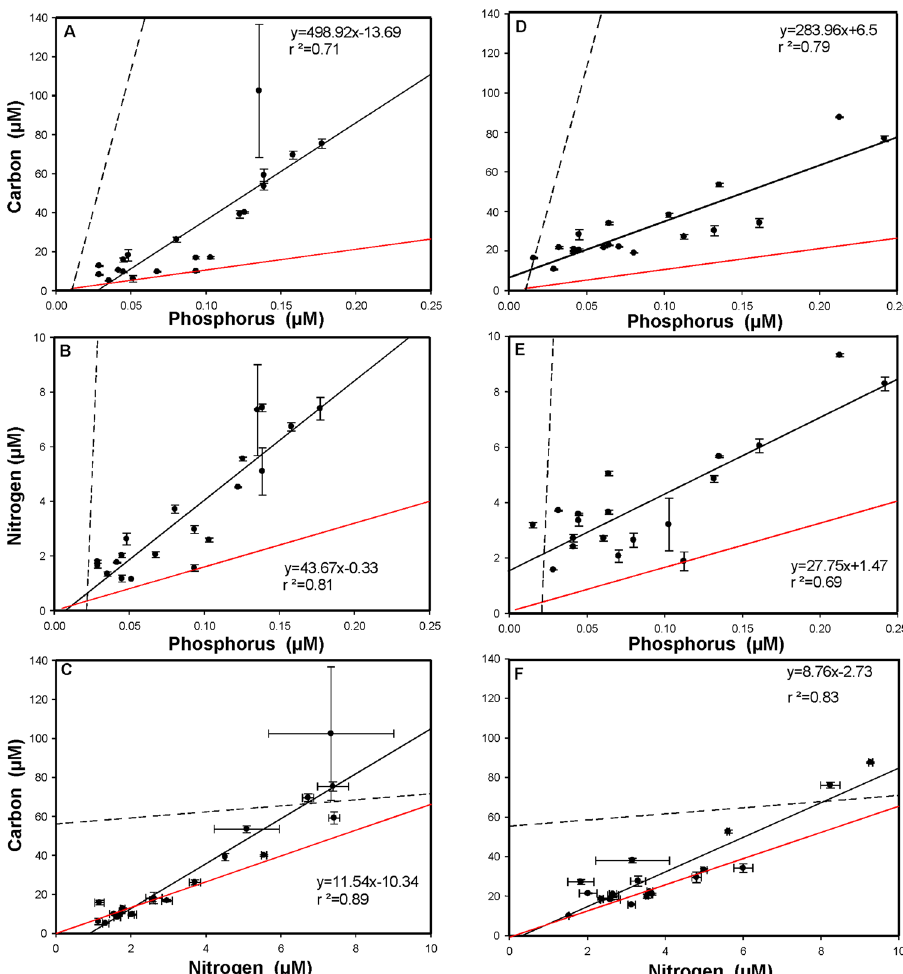
Figure 2. Regression analysis between the concentration carbon, nitrogen, and phosphorus in the seston size (0.7–50 µ m) fraction in July ( A , B , C ) and in October ( D , E , F ). The red line represents the Redfield ratio of these elements, the continuous line represents the regression of the seston fraction (with corresponding equation) and the dotted line that for the pooled dissolved